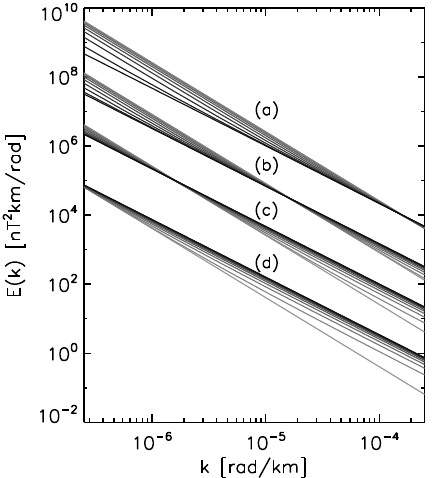
Figure 2. One-dimensional streamwise energy spectra obtained from the non-elliptic two-dimensional spectra for the four coeffi- cient sets shown in Fig. 1. The spectra are obtained for projection angles θ VB from the mean magnetic field from 0 ◦ (parallel pro- jection, in gray) to 90 ◦ (perpendicular projection, in black) at 10 ◦ steps. The spectra are shifted on the logarithmic scale to separate among the four cases.